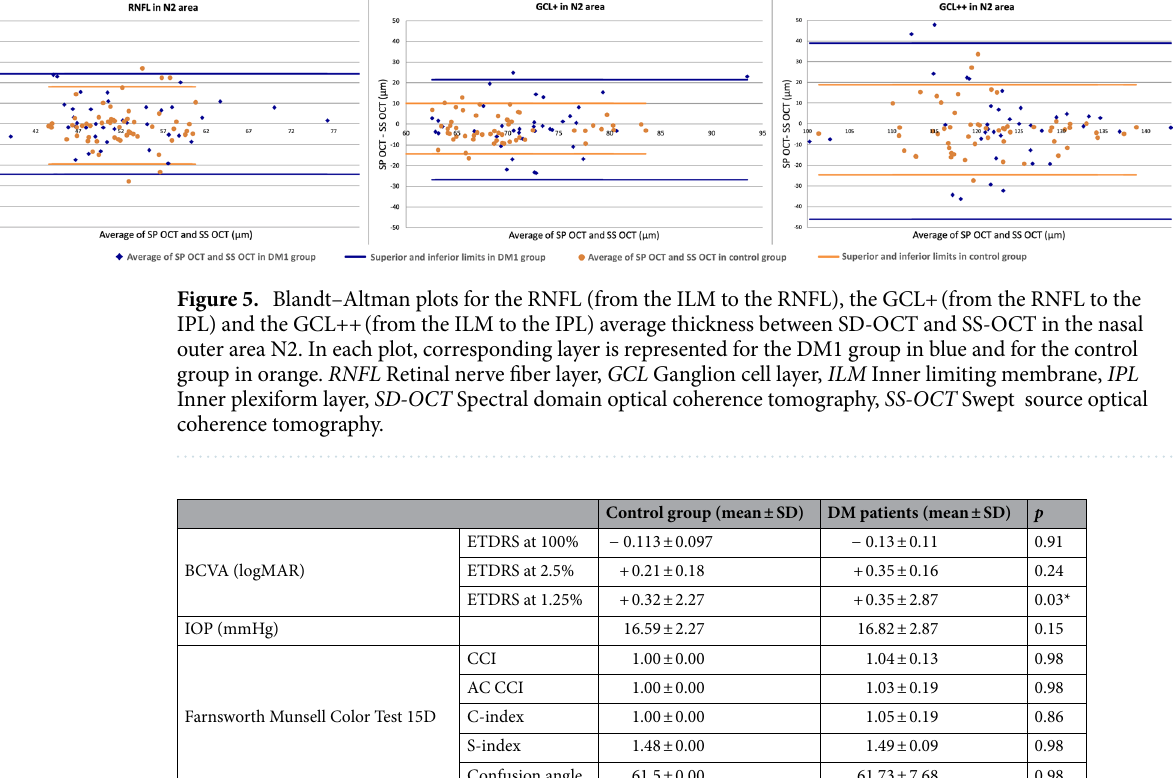
Table 1. Mean and standard deviation (SD) of the visual function parameters obtained in the control group and in DM1 patients and their comparison ( p value). The differences that reached statistical significance ( p < 0.05) are indicated with *. DM1 Diabetes mellitus, SD Standard deviation, BCVA Best corrected visual acuity, IOP Intraocular pressure, ETDRS Early Treatment of Diabetic Retinopathy Study, CCI Color confusion index, AC-CCI Age-corrected color confusion index, C-index Confusion index, S-index Selectivity index.